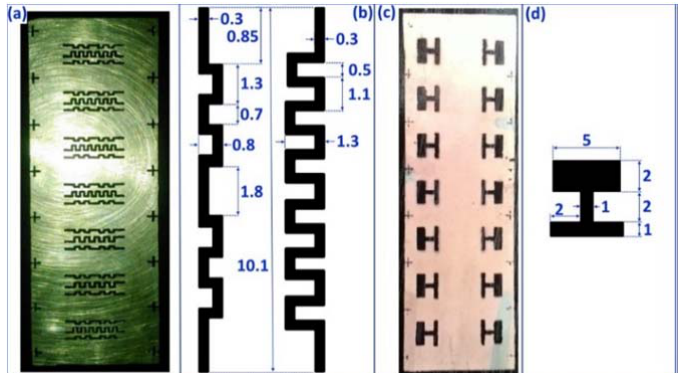
Figure 2. (a) Optical image of the mask used for micro-heaters fabrication, which is made from a thin copper foil. (b) Geometrical parameters of the heating elements (units are in mm) for mask from (a). (c) Mask for contacts deposition for heaters shown in (a); and (d) geometrical parameters of one